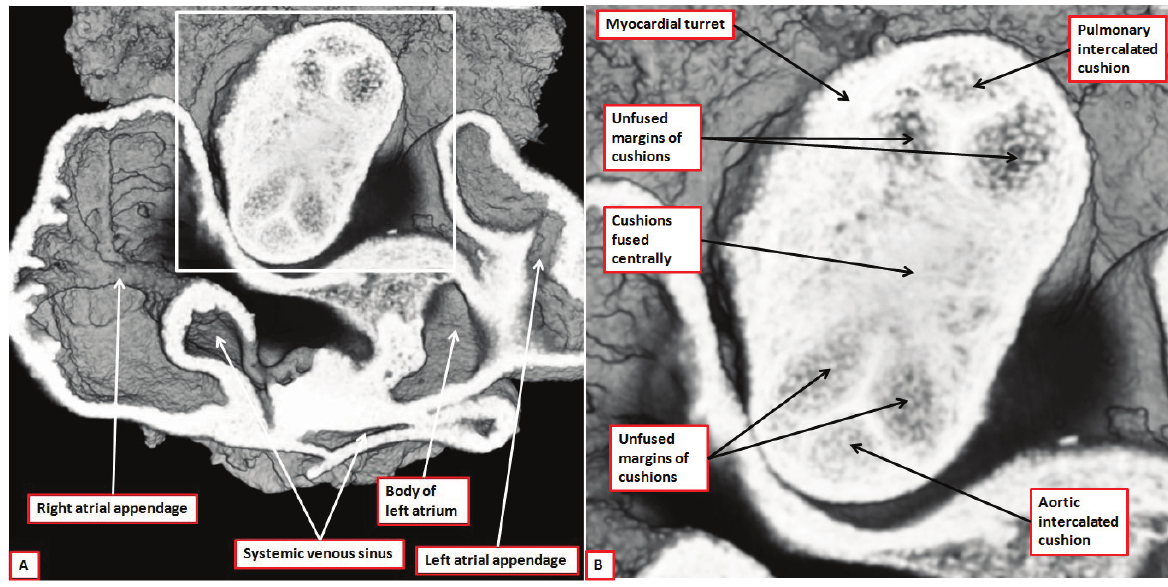
Figure 10. The images are from an episcopic dataset prepared from a developing mouse at E12.5. Panel ( A ) shows an overall short-axis section through the atrial chambers, taken obliquely across the intermediate part of the outflow tract so as to cut through both the intercalated cushions. Panel ( B ), which is a magnified image of the boxed area in panel ( A ), shows how the intercalated cushions interpose between the unfused parietal margins of the major outflow cushions, thus forming the primordiums of the arterial